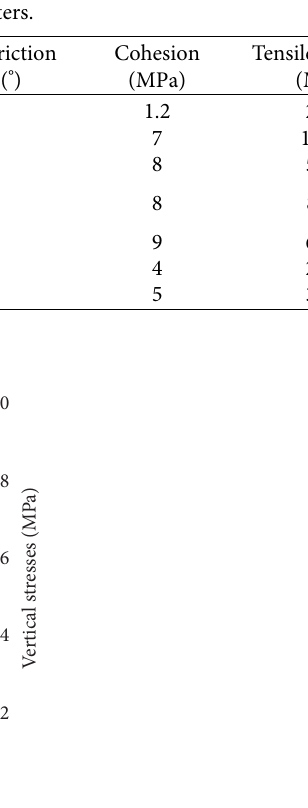
Figure 13: Stress distribution